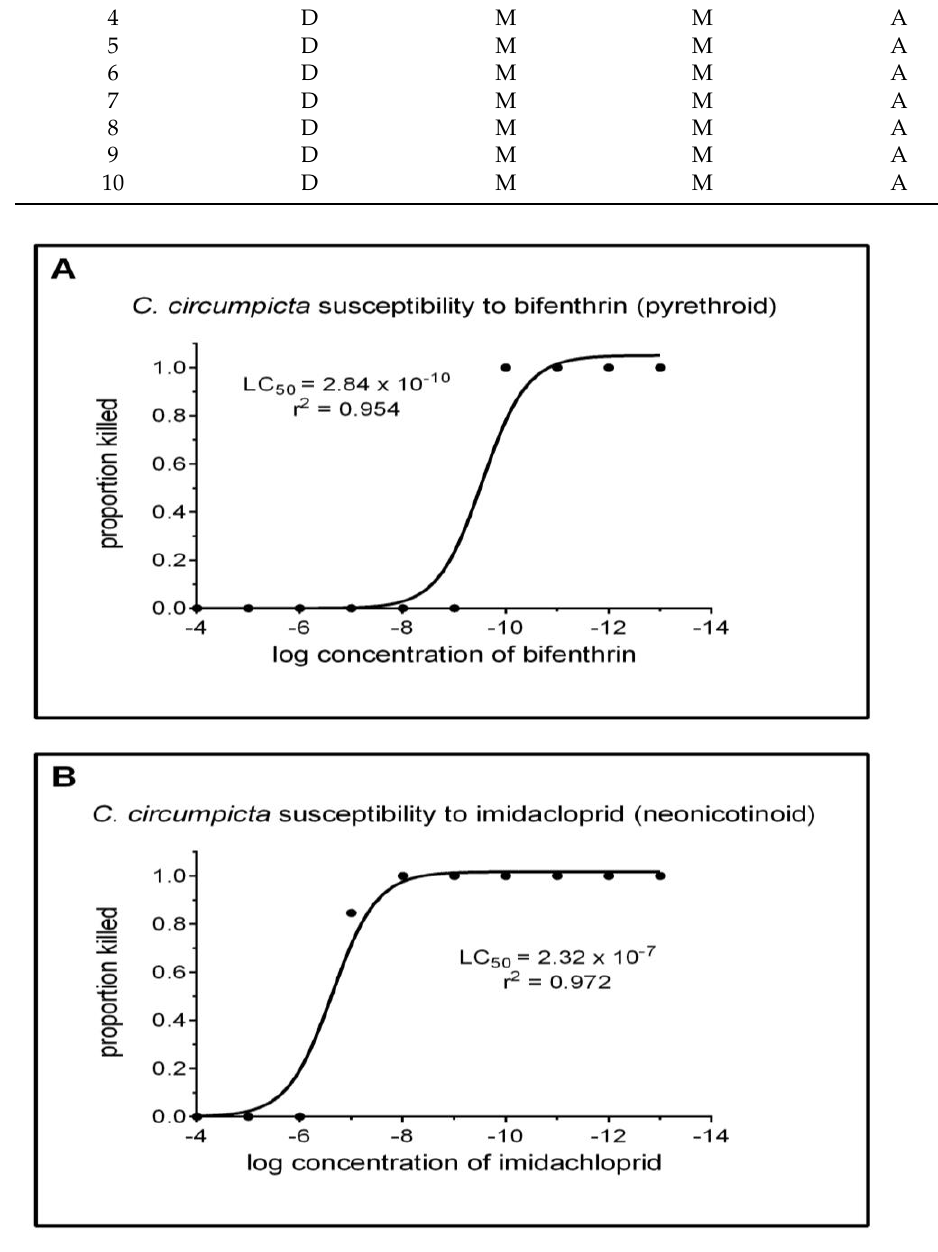
Figure 1. Susceptibility of first stage C. circumpicta to contact exposure by a pyrethroid and neonicotinoid after 48 h. ( A ) indicates susceptibility to bifenthrin, with dose – response curve and calculated LC50; ( B ) indicates susceptibility to imidacloprid, with dose – response curve and calculated LC50.